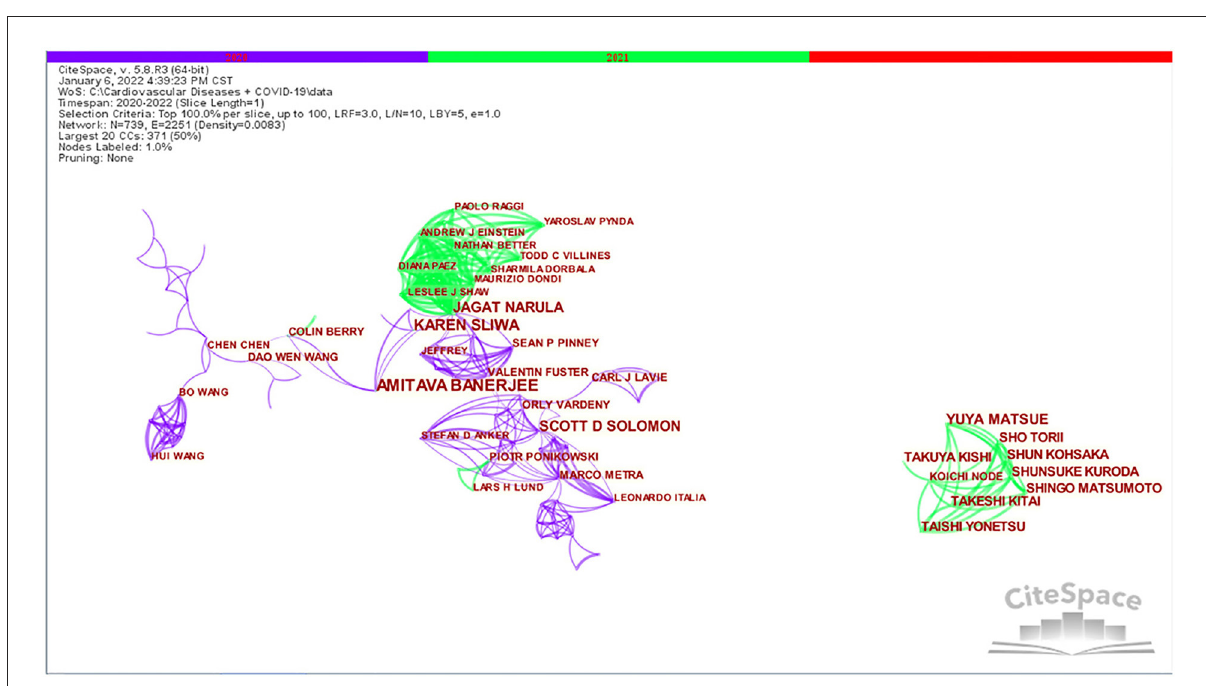
FIGURE4 Visualization map of authors in the studies of CVDs and COVID-19